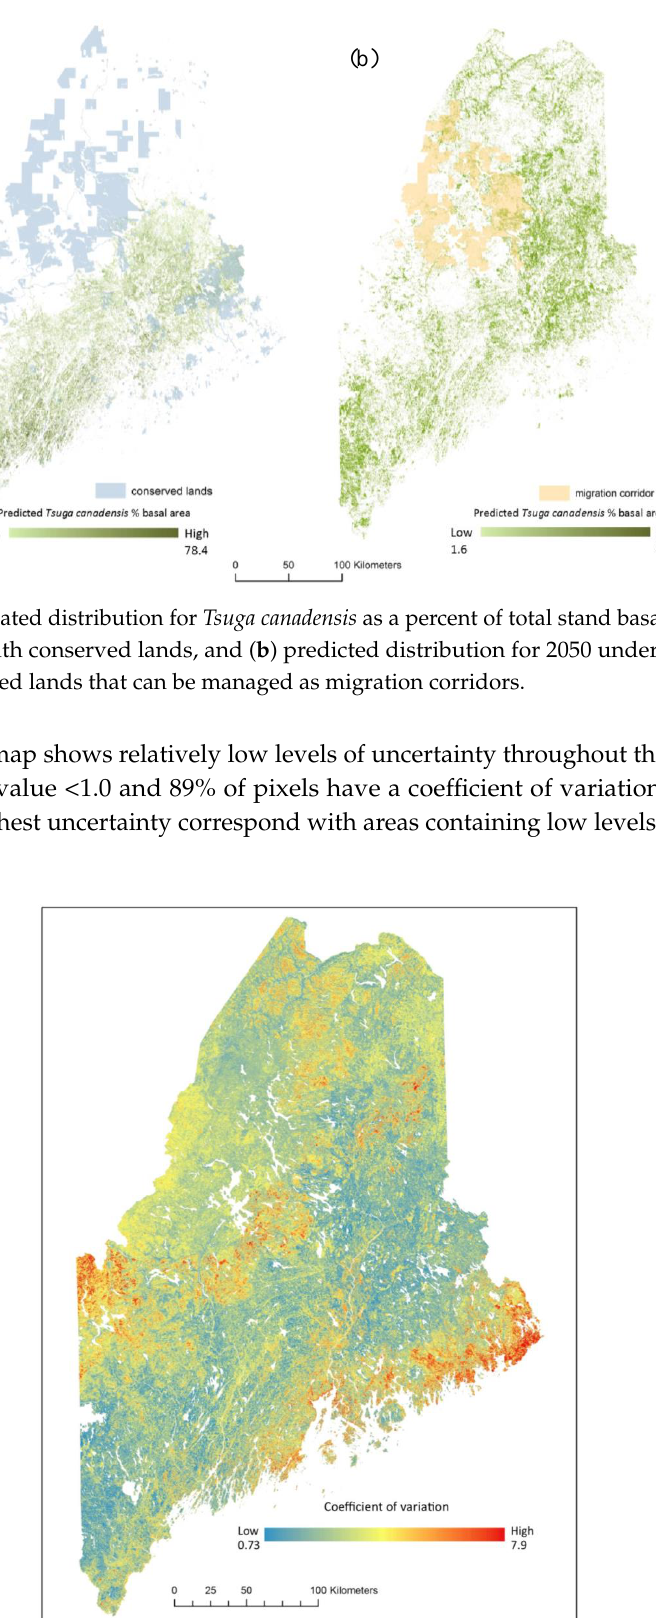
Figure 7. The range of precipitation and corresponding Tsuga canadensis basal area values of 2000 randomly generated points across Maine for ( a ) RCP 4.5 (2050), ( b ) RCP 4.5 (2100), ( c ) RCP 8.5 (2050), and ( d ) RCP 8.5 (2100).